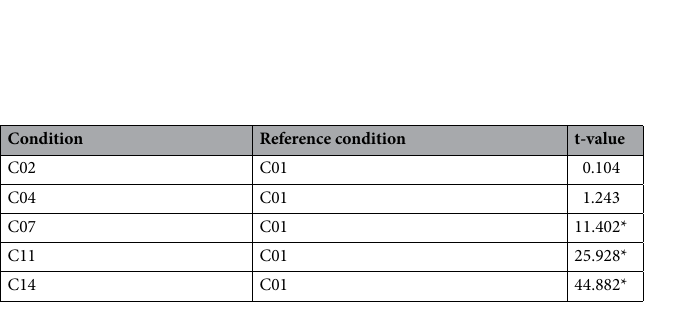
Table 2. t-Test: results of reference studio condition with increasing watermark strength. Statistically important differences ( α = 0.05 critical value 1.662) are marked with *character.